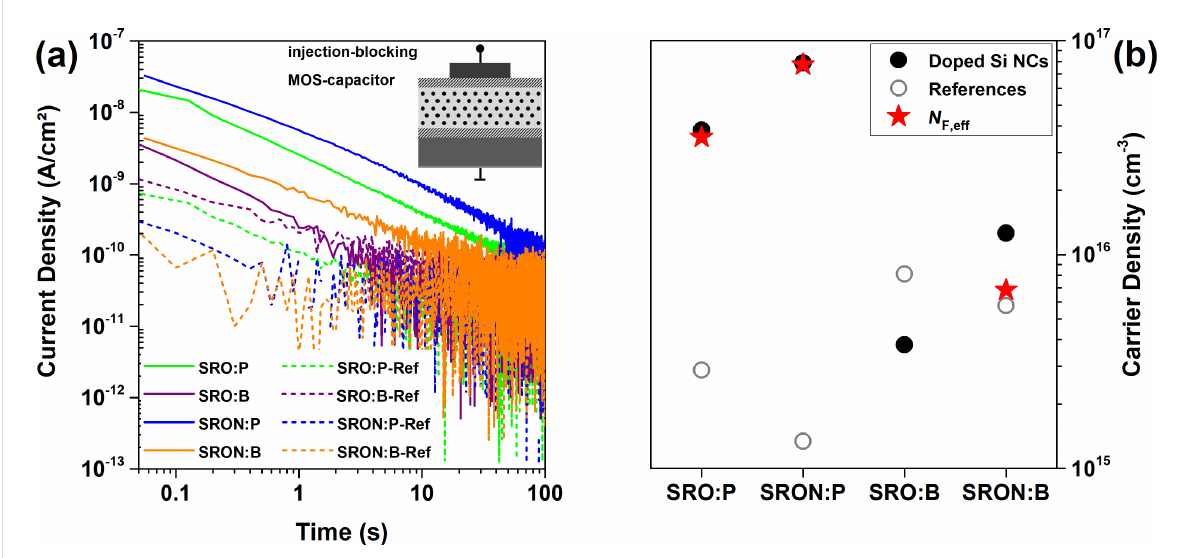
Figure 7: (a) J – t transients of the same MOS-capacitors as in the previous figure measured at E = 0.2 MV/cm. The inset shows a schematic cross- section of the device under test. (b) Free carrier density from field ionization of substitutional dopants derived from integrating transient current over time. For effective free carrier values ( N F,eff ) the values of the dopant-free references values are subtracted from the values of the doped Si NC sam-